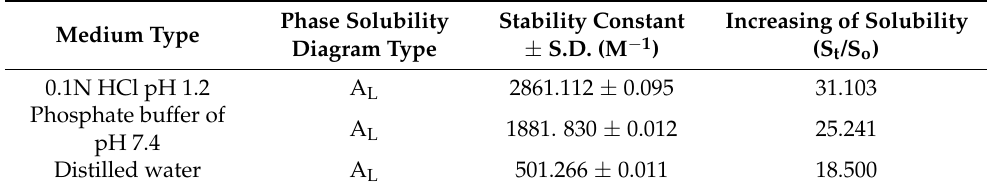
Figure 2. Phase solubility diagrams of FZ in the presence of different concentrations of sulfonatecalix[4]naphthalene at temp. 25.5 ± 0.5 °C. ( A ) pH 1.2, ( B ) phosphate buffer pH 7.4, ( C ) distilled water. ( n = 3, ± S.D.). Table 1. The phase solubility study of the Fluconazole-sulfonatocalix[4]naphthalene complex at different media.